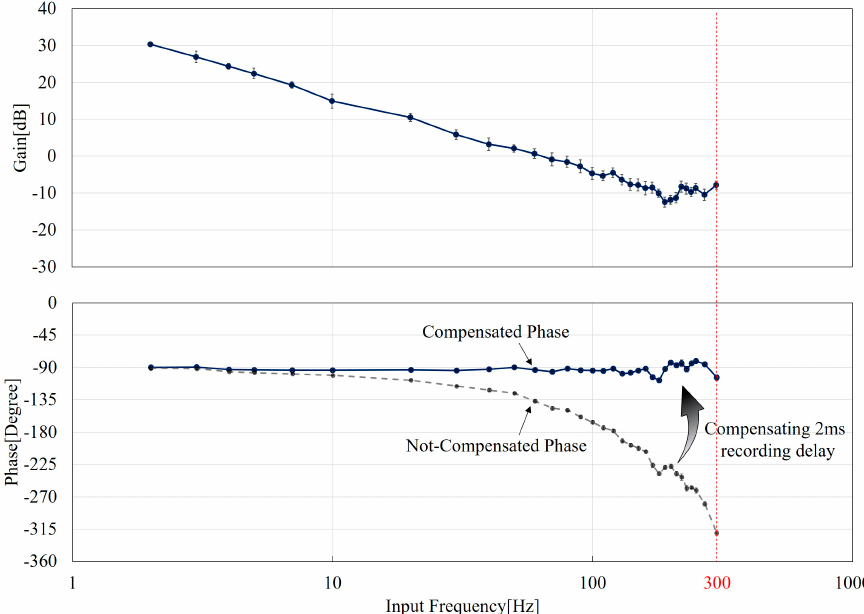
Figure 7. The Bode plots from experimental results. The upper and lower plots are the gain and phase response, respectively. The delay of 2 ms in the recording system is essential for the phase. Both before and after the compensation plots are shown.